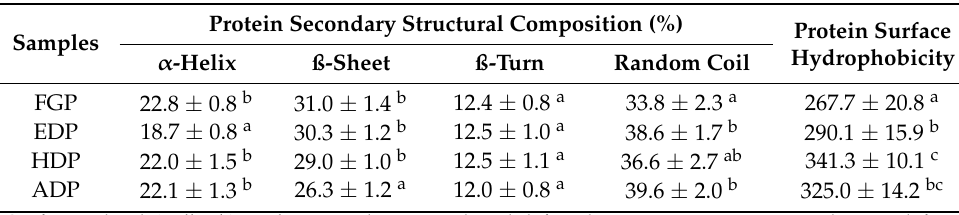
Table 3. Protein secondary structural composition and surface hydrophobicity of soluble proteins from G. bimaculatus and three defatted protein